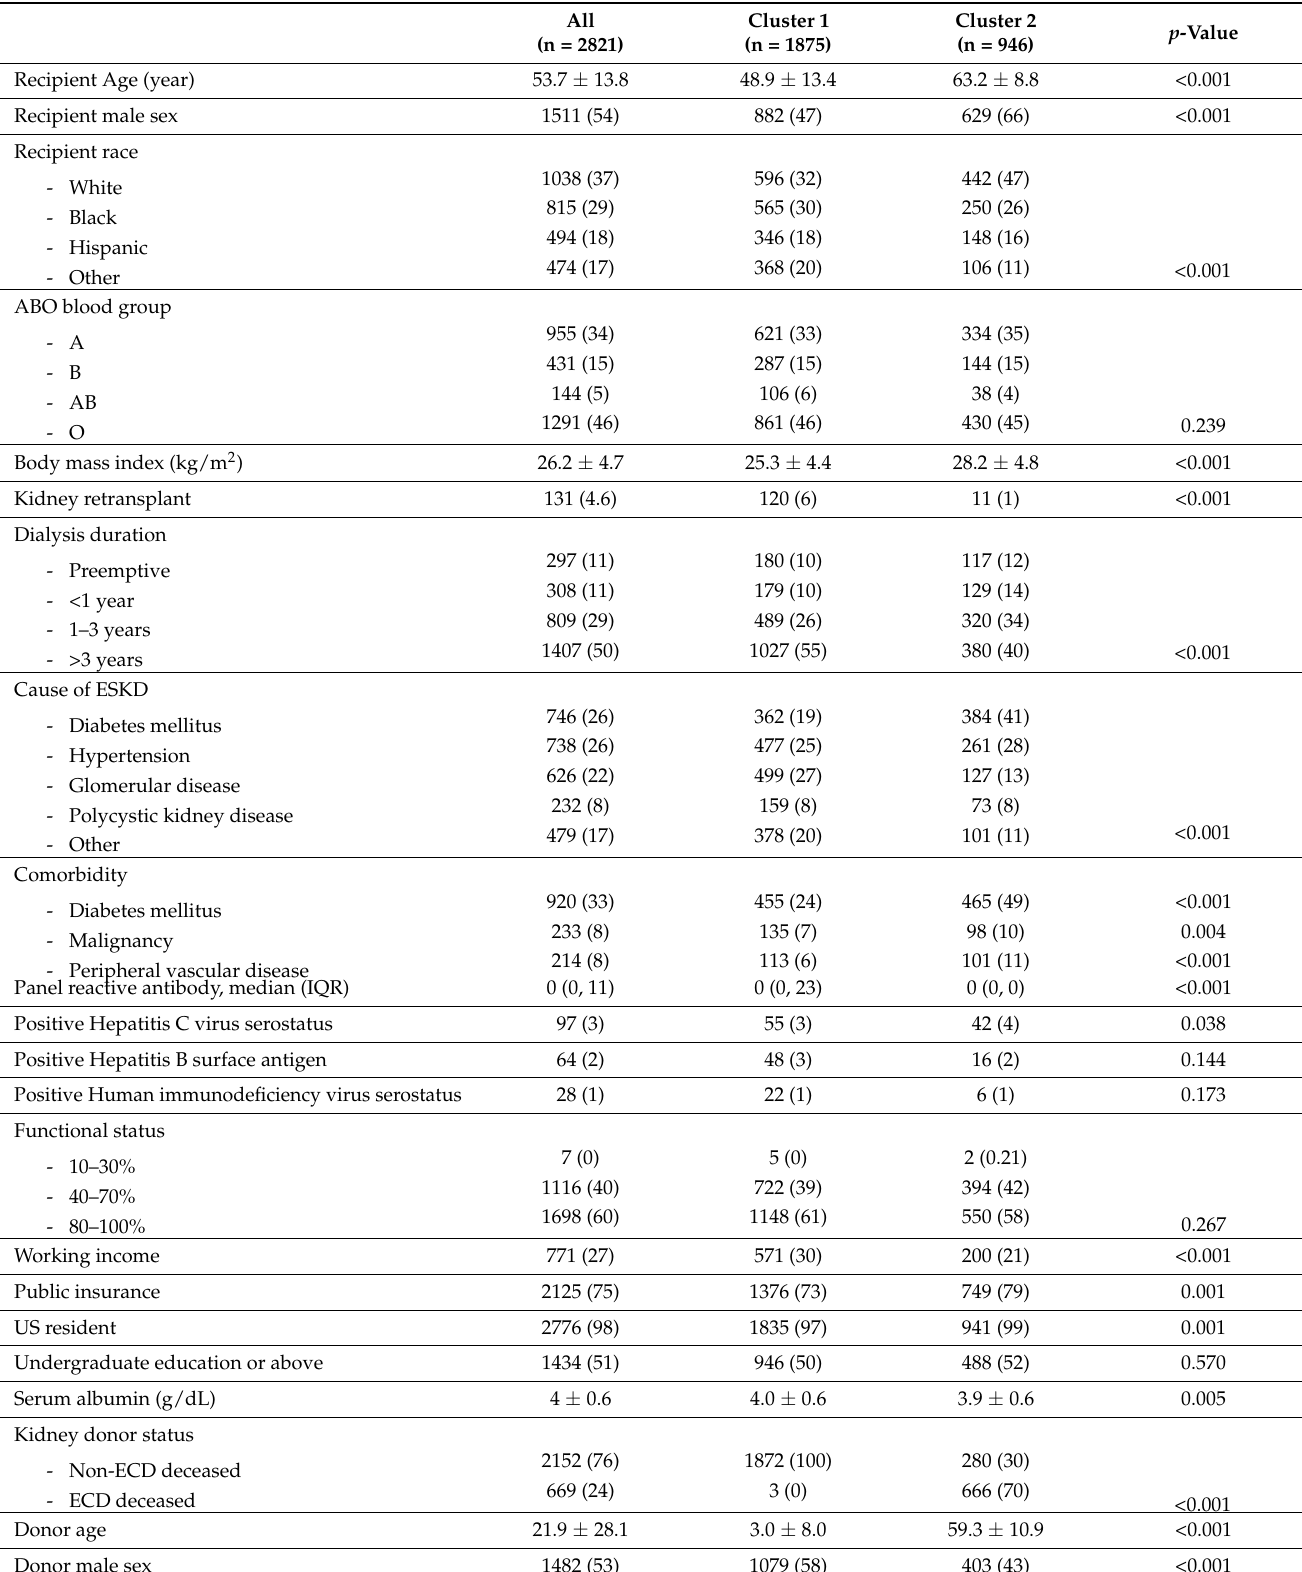
Table 1. Clinical characteristics of DKT patients according to the assigned